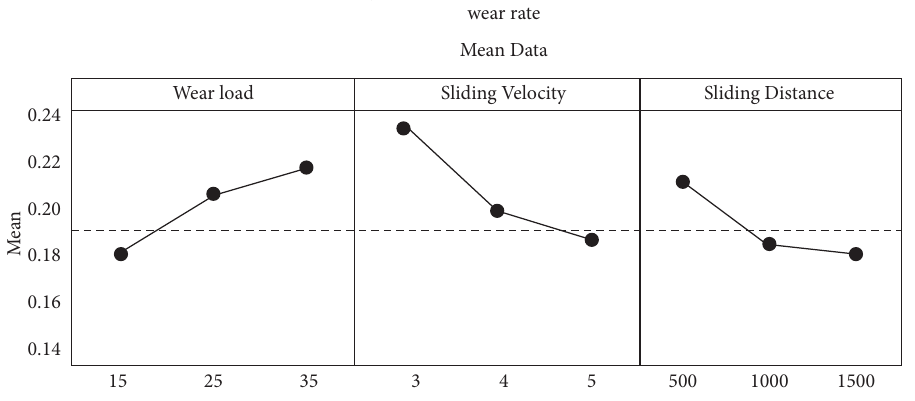
Figure 3: Main effects plot for wear rate (AAZrB